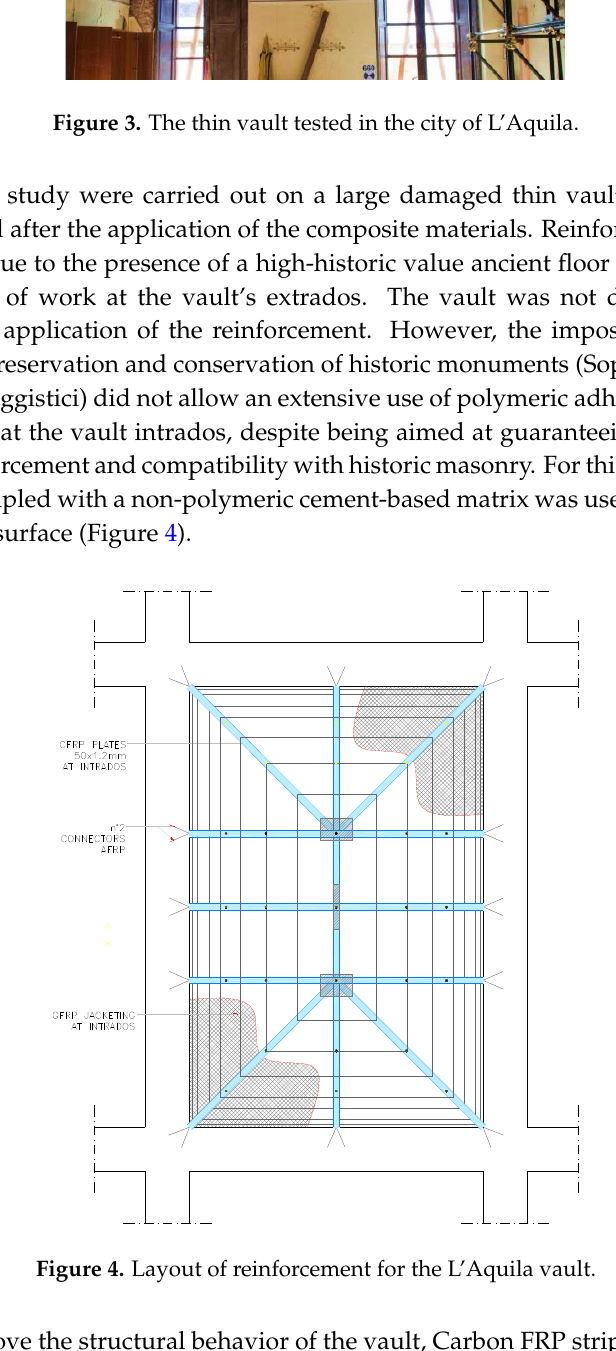
Figure 4. Layout of reinforcement for the L’Aquila vault.